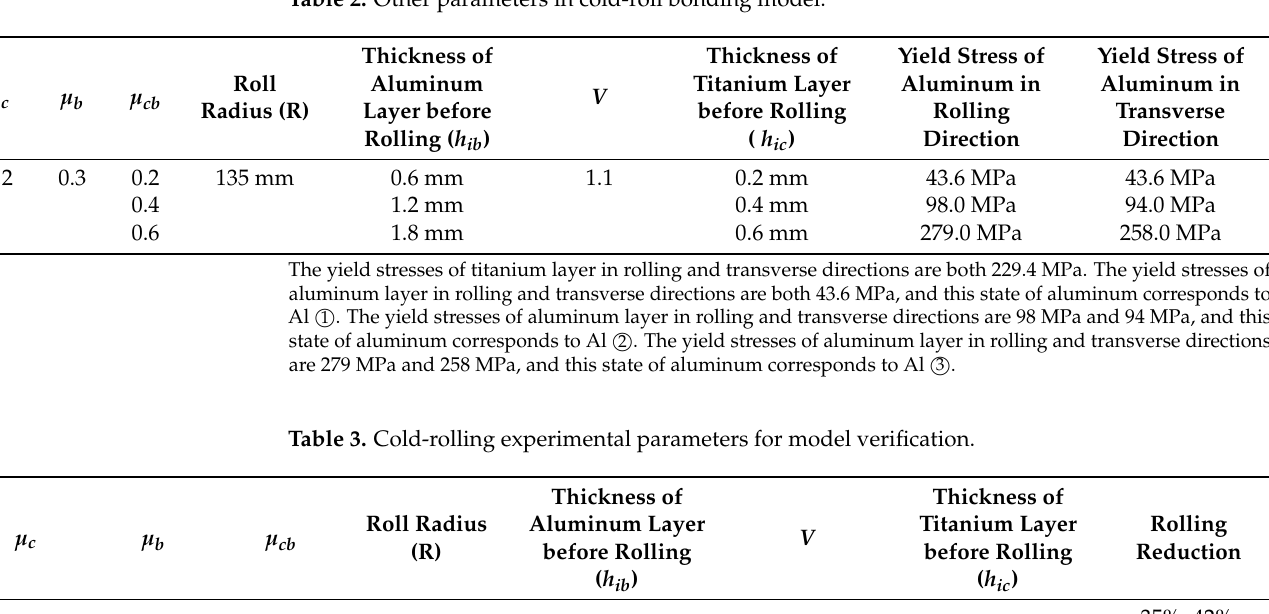
Table 2. Other parameters in cold-roll bonding model.